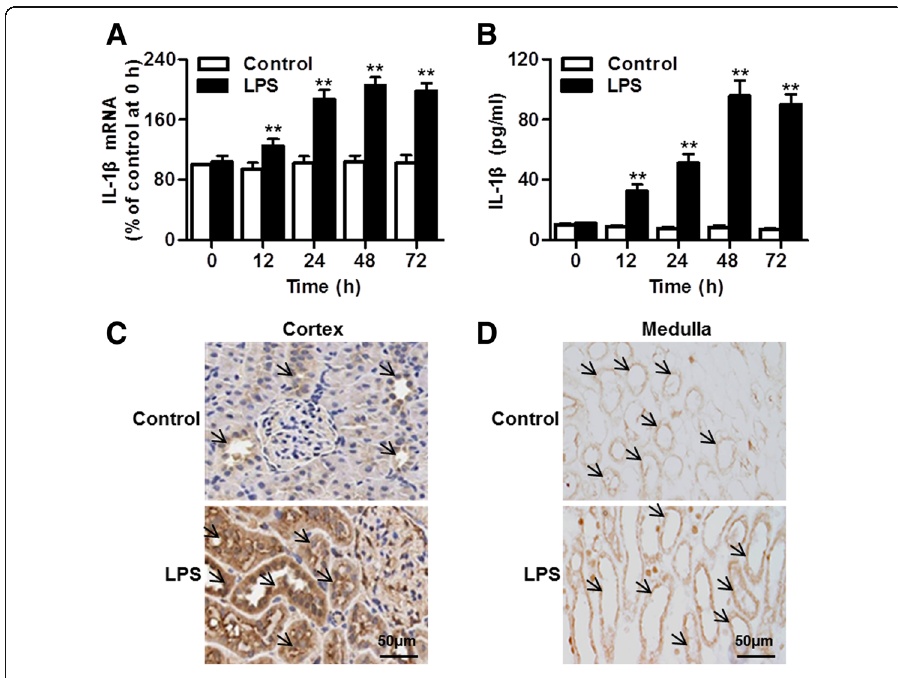
Fig. 1 LPS induced IL-1 β level in mouse kidney tissues. a Interleukin-1 β (IL-1 β ) mRNA expression was analyzed in kidney tissues from control or lipopolysaccharide (LPS)-treated mice by real-time PCR at the times as indicated. LPS time-dependently increased the IL-1 β mRNA expression. b ELISA analysis showing time-dependent increase of renal concentrations of IL-1 β after LPS treatment for 72 h compared with control group. ** P < 0.01 vs. control, n = 8 in each group. c and d Immunohistochemical protein expression of IL-1 β in renal cortex ( c ) and medulla ( d ) of mice after 72 h of LPS treatment (magnification, 200×). Arrows indicate the positive staining area of IL-1